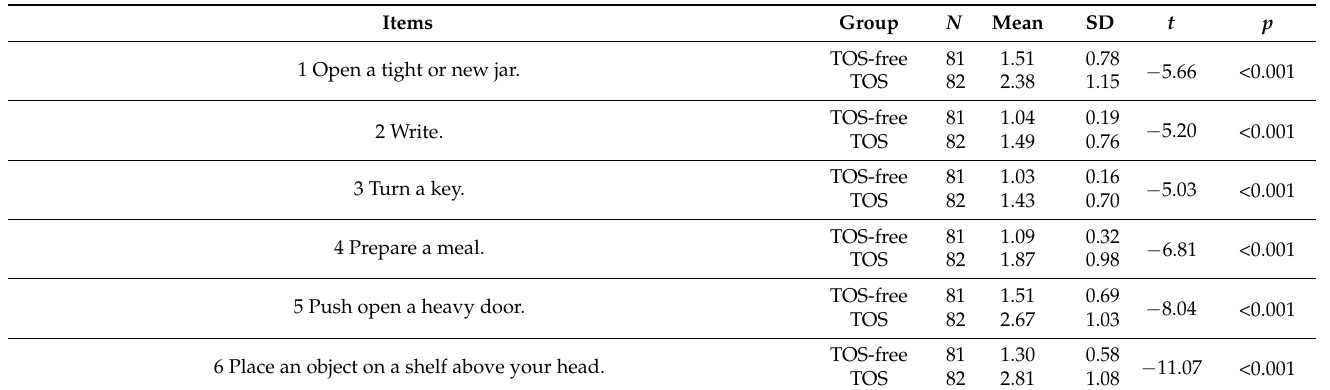
Table A1. Difference between TOS i TOS-free groups on DASH questionnaire